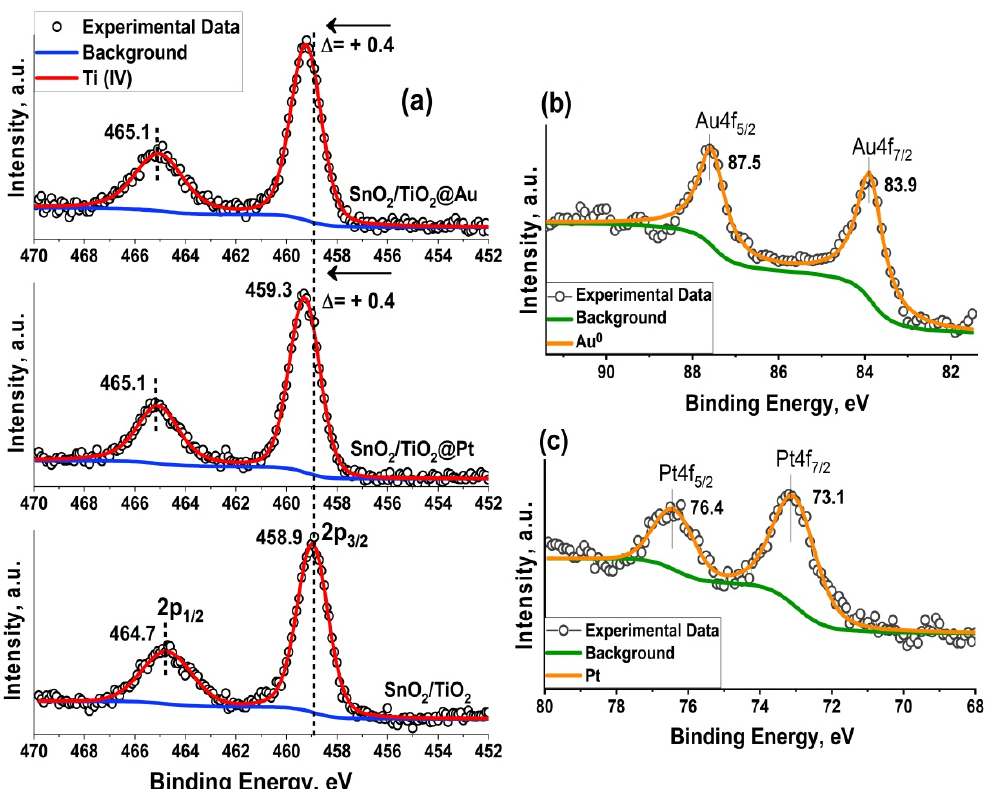
Figure 5. Ti 2p ( a ), Au 4f ( b ) and Pt 4f ( c ) XP-spectra of the synthesized samples. Figure 5b,c shows the deconvoluted Pt 4f and Au 4f spectra, respectively. Accord- ing to [40,42,43], the peaks located at 73.1 eV (Pt 4f 7/2 ) and 76.4 eV (Pt 4f 5/2 ) may be asso- ciated with Pt (II) in PtO or Pt(OH) 2 . However, the FTIR spectra (Figure S6, Supplemen- tary Materials) showed that the amount of the hydroxyl groups is almost similar in all samples. Therefore, we can conclude that platinum in the composite is in the oxidized form of PtO. The long-term (24 h) and high-temperature (300 °C) annealing could lead to oxidation of the surface layer of platinum nanoparticles. The Au 4f XP-spectrum indi- cates the presence of only metallic Au NPs [40]. The method of temperature-programmed reduction of hydrogen (TPR-H 2 ) was used to study the oxidative active centers on the surface of the samples. The TPR curves are shown in Figure 6. The profiles of hydrogen consumption can be divided into two temperature regions: the low-temperature one (T = 100–300 °C) corresponds to the re- duction of the surface oxygen-containing species. The high-temperature region (T = 400– 750 °C) corresponds to the reduction of SnO 2 to metallic Sn. A small shoulder can be ob- served in the high-temperature region at T = 460–465 °C that corresponds to a partial re- duction of SnO 2 to SnO.